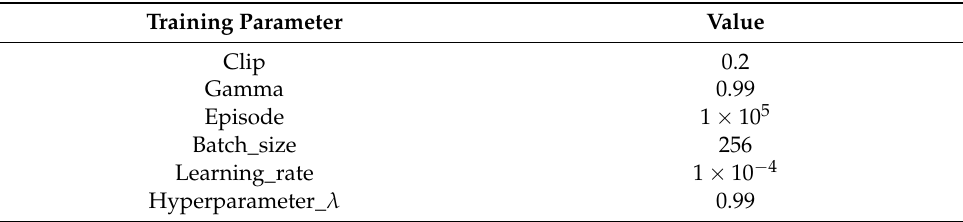
Table 3. The setting of training